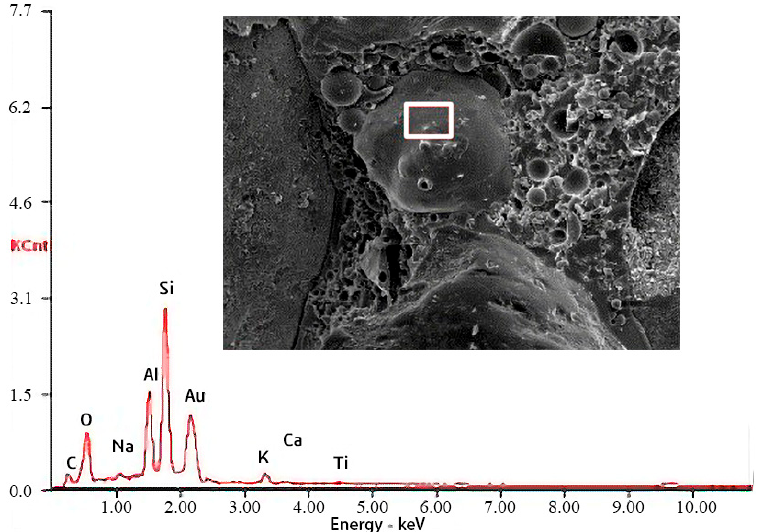
NPG; ( b ) corroded NPG; ( c ) uncorroded LPG; ( d ) corroded LPG. Figure 9. SEM images of the interior of specimens immersed in pH 0.5 acid solution: ( a ) uncorroded